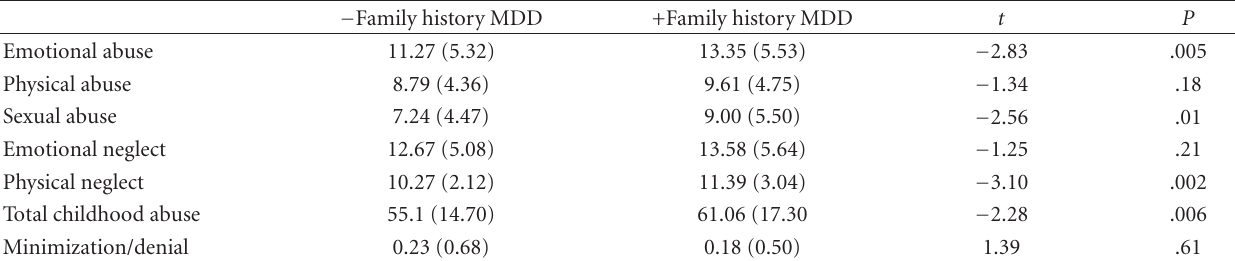
Table 1: Childhood trauma questionnaire subscale values by family history of